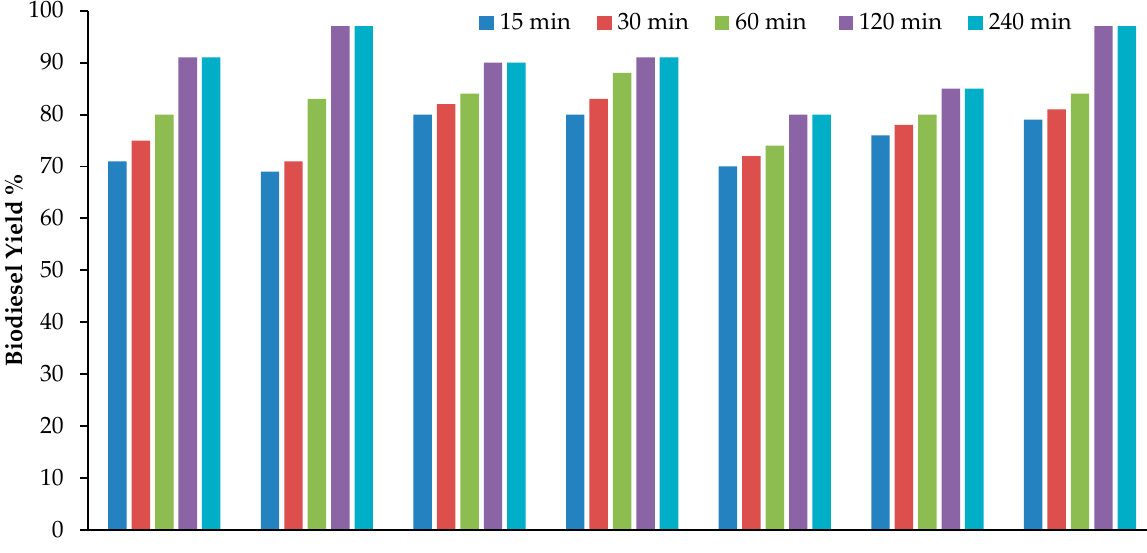
Figure 2. Effect of methanol concentration on biodiesel yield (catalysts concentration, 1 g; temperature, 60 °C; time, 120 min).